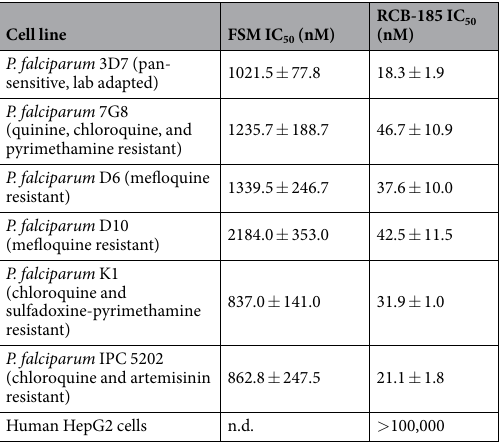
Table 1. RCB-185 is active against multidrug resistant P. falciparum .